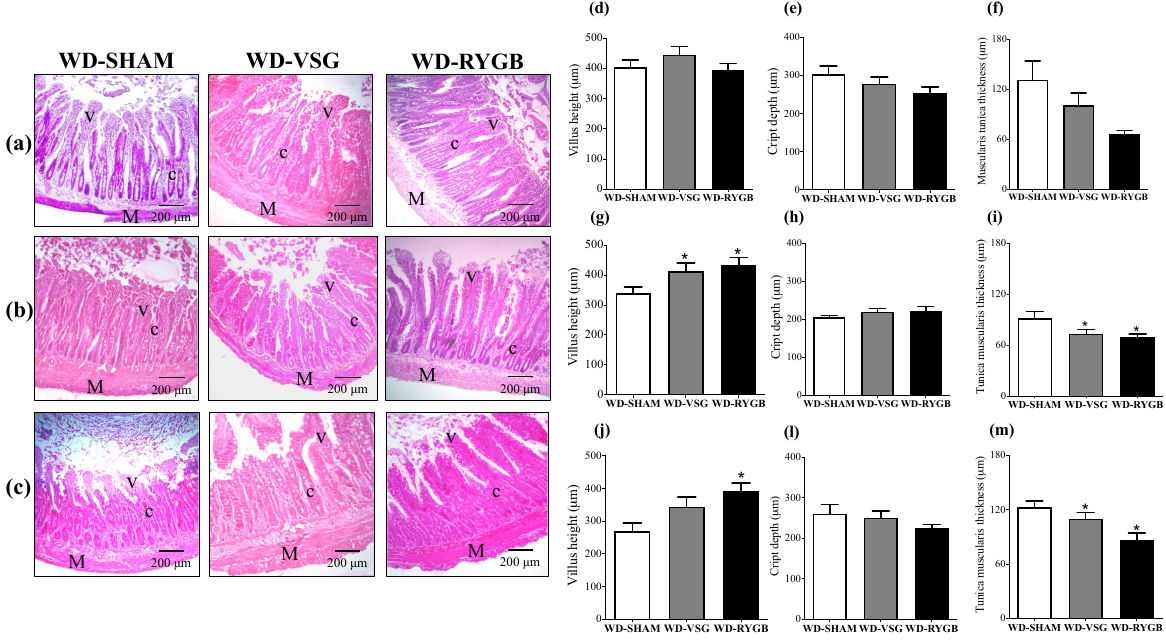
Figure 7. Representative images of 5-μm-thick sections of the duodenum (a), jejunum (b) and ileum (c) of WD- SHAM, WD-VSG and WD-RYGB rats at 3 months after operations. Means ± SEM of the villi height (d, g and j), crypt depth (e, h and l) and tunica muscularis thickness (f, i and m) of the duodenum, jejunum and ileum, respectively, in the small intestine of WD-SHAM (n = 5), WD-VSG (n = 5) and WD-RYGB (n = 5) rats. *different from WD-SHAM (Kruskal-Wallis followed by Dunns, P <